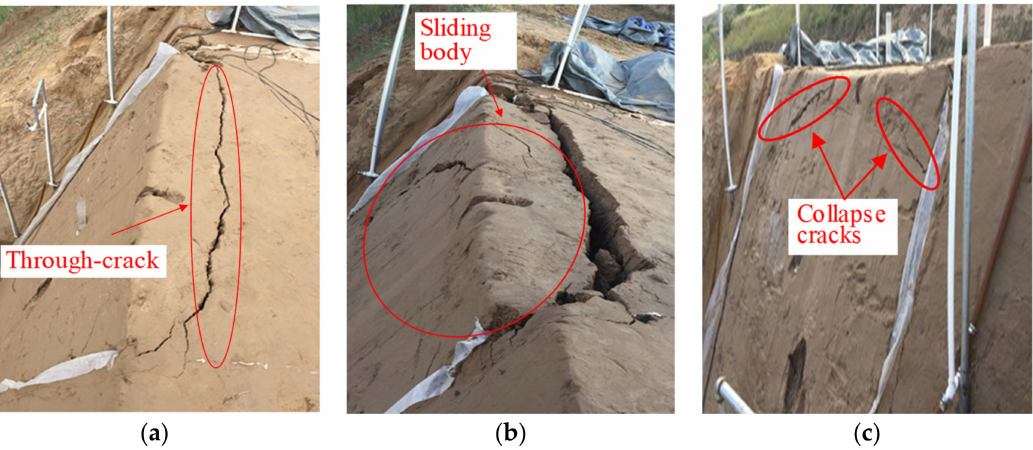
Figure 7. Cracking of the slope under rainstorm: ( a ) through-crack at the slope crest; ( b ) sliding body of the slope; ( c ) collapse cracks at the slope